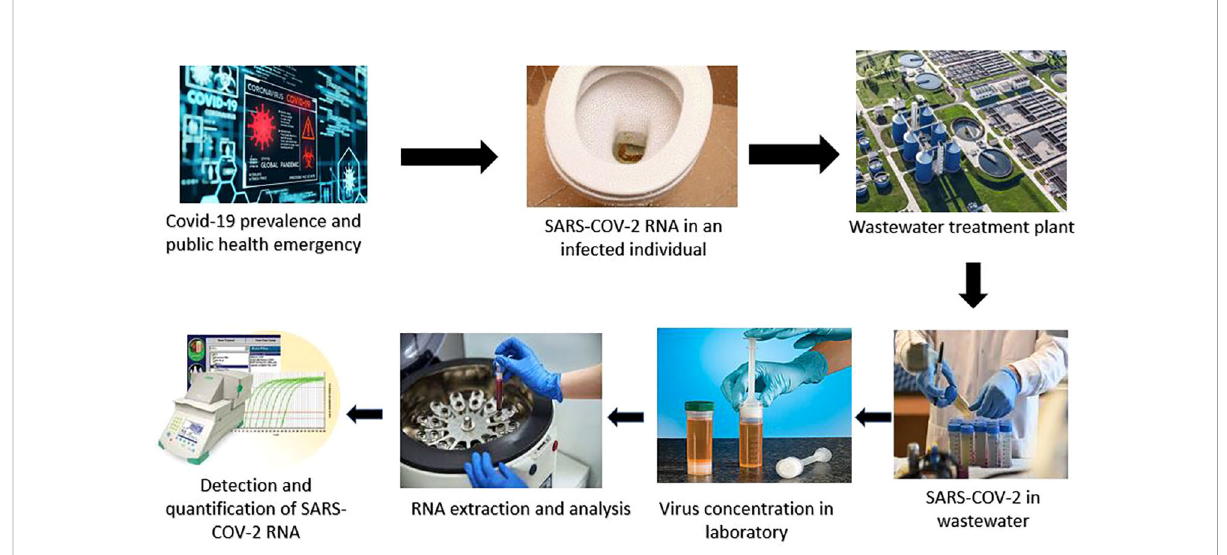
FIGURE 1 Steps of wastewater-based epidemiology (WBE) by testing wastewater to monitor the outbreak of